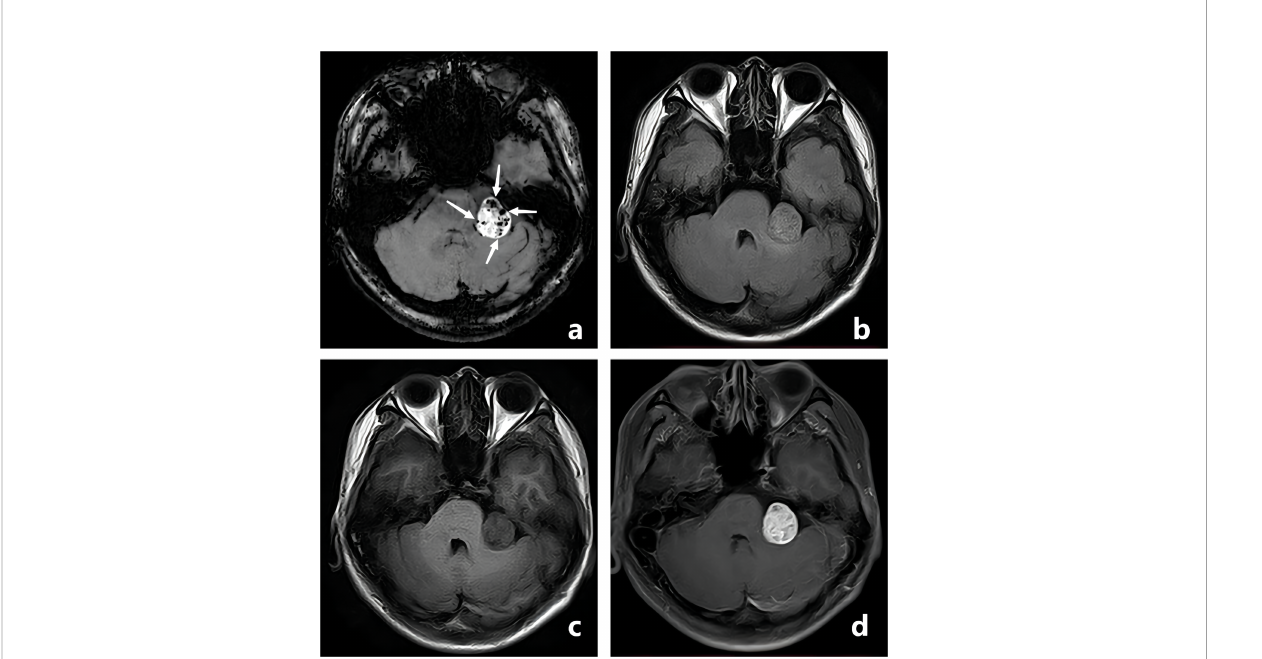
FIGURE 3 A-28-year-old man with a pathologically con fi rmed schwannoma in his left cerebellopontine angle area after surgical resection. The schwannoma showed obvious inhomogeneous enhancement, and the intratumoral microbleeds showed speckled low signals on CE-T 1 WI FSBB ( A , white arrows). Microbleeds were not clearly visible on FLAIR (B) , T 1 WI (C) , and CE-T 1 WI (D) .